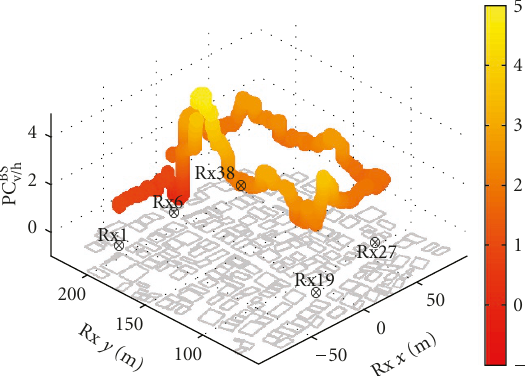
of the DMCs Δ s = 20 (ca 3m). v